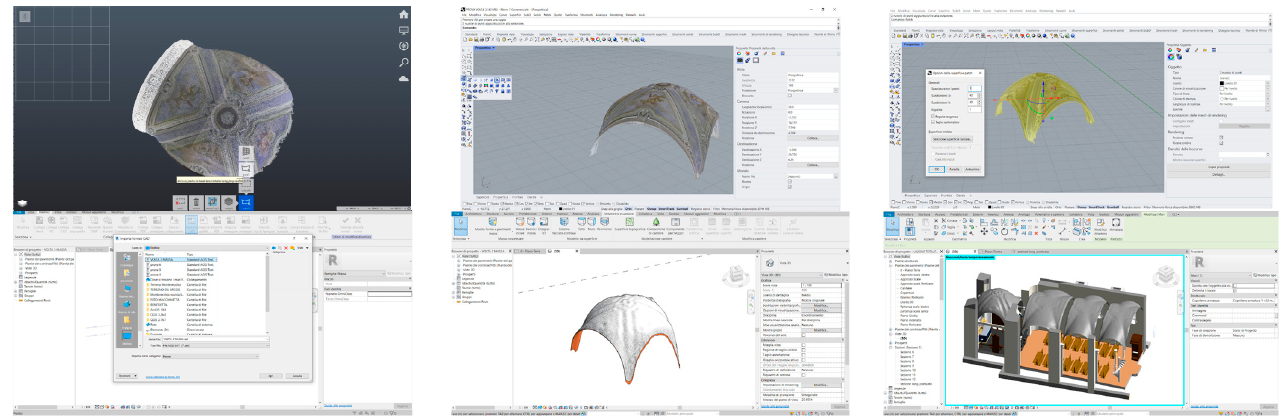
Figure 12. Different modelling phases of the vaults: cleaning in Autodesk Recap Pro to NURBS modeler: first row cleaning in Recap ( on the left ), patch progress in Rhinoceros software ( in the center and right ); second row import phase into the BIM environment ( on the left and center ) and in the final model ( on the right ).